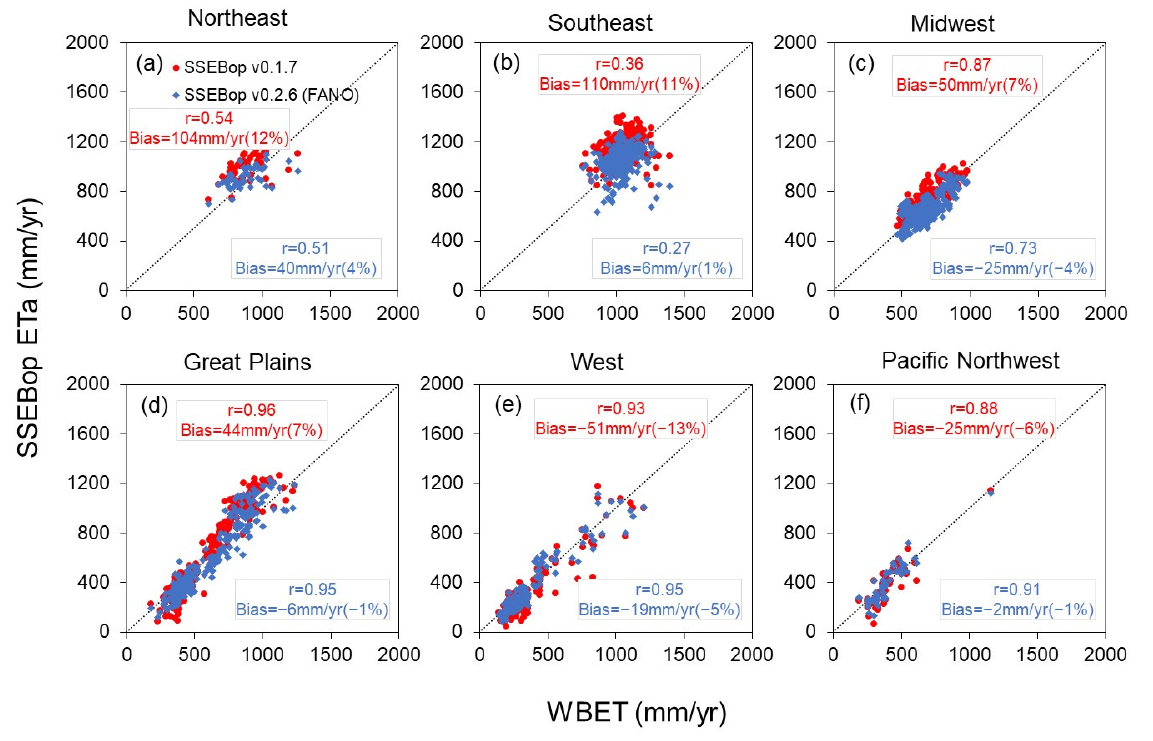
Figure 8. Comparison of annual ETa from SSEBop v0.1.7 and SSEBop v0.2.6 (FANO) with water balance (WBET) across HUC8s at six different regions of the conterminous United States. Subfigures ( a ), ( b ), ( c ), ( d ), ( e ), and ( f ) show the ET comparisons for Northeast, Southeast, Midwest, Great Plains, West, and Pacific Northwest regions, respectively.